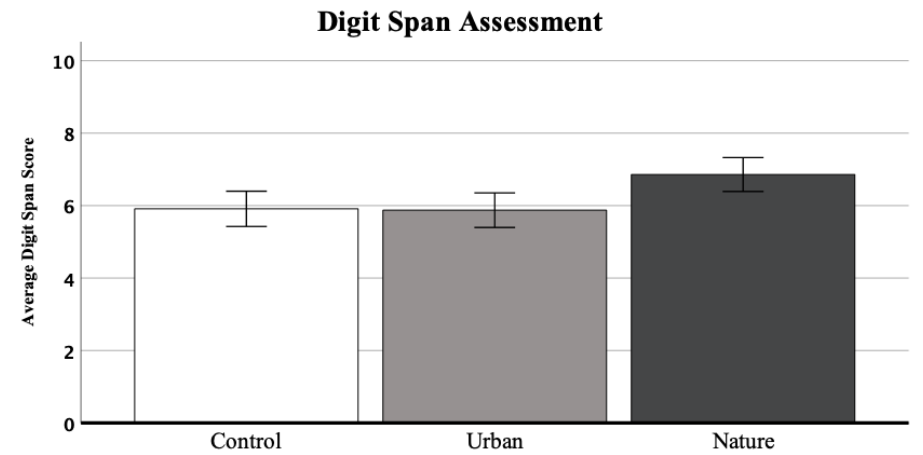
Figure 3. Mean Digit Span Score per Restorative Condition; Control, Urban, and Nature.